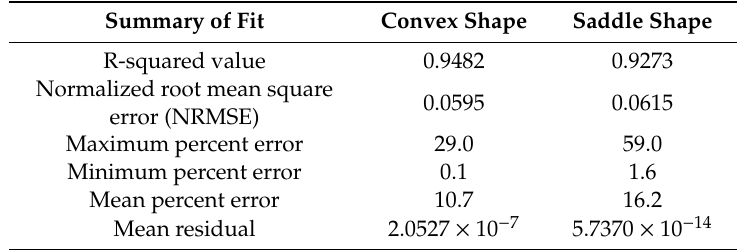
Table 7. Summary of results of the goodness of fit tests.